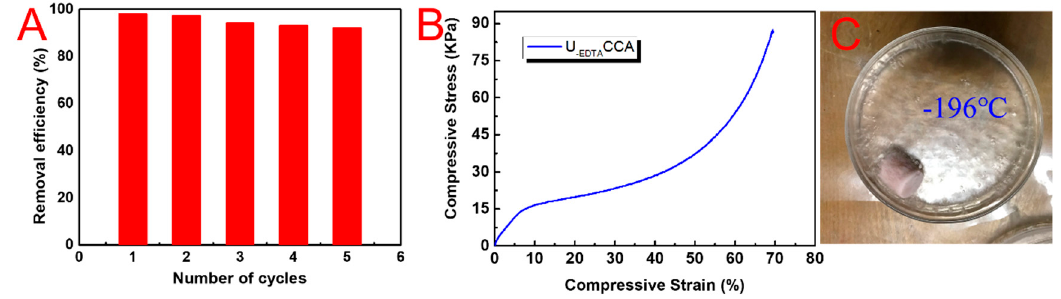
Figure 8. ( A ) Removal efficiency of Cr 3+ of U -EDTA CCA; ( B ) compressive stress–strain curve of U -EDTA CCA; and ( C ) the stability of U -EDTA CCA at − 196 °C.